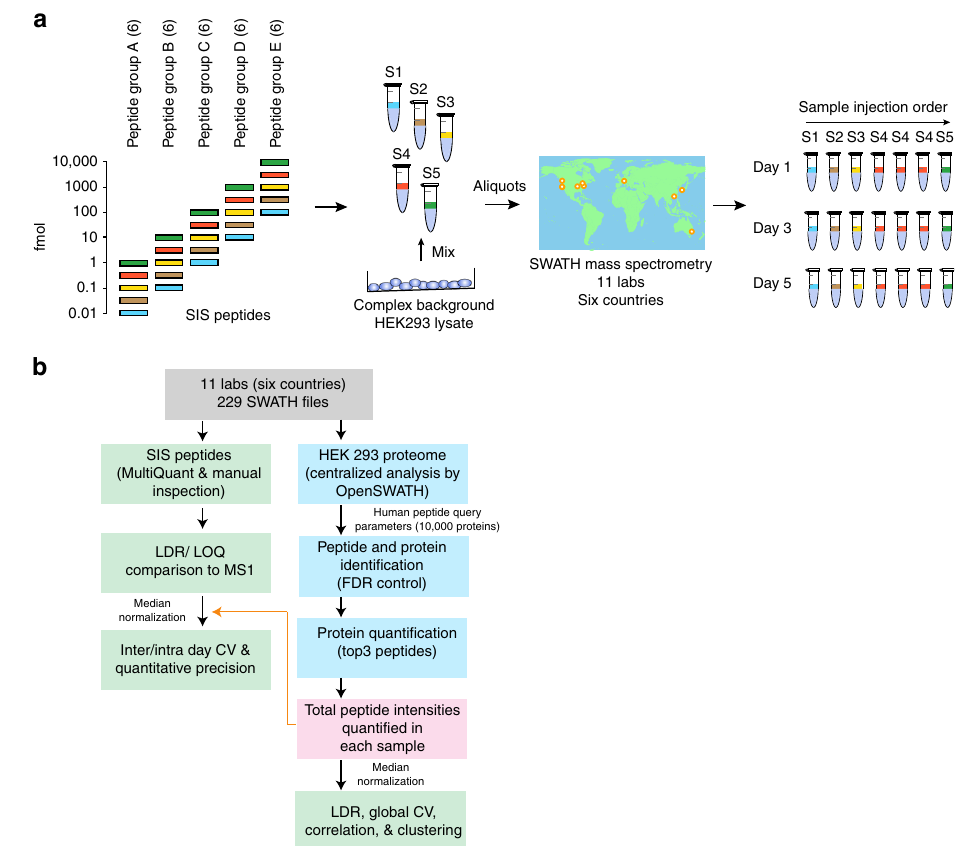
Fig. 1 Study design and implementation. a A set of 30 SIS peptides partitioned into fi ve groups (A – E, six peptides in each) were diluted into a HEK293 cell lysate to span a large dynamic range. Starting at a different upper concentration for each group, they were threefold diluted into the matrix to cover a concentration range from 12 amol to 10 pmol in 1 µ g of cell lysate. This created a set of fi ve samples to be run by SWATH-MS on the TripleTOF 5600/5600+ system at each site. Each sample was run once per day on day 1, 3, and 5, with the exception of sample 4 which was run 3× on each day. b After data acquisition, the 229 SWATH-MS fi les were assembled centrally and processed using two strategies. The SIS peptide concentration curves were assessed using MultiQuant Software, allowing for the determination of linear dynamic range ( LDR ), and LLOQs for each peptide. In addition, the intra- and inter-day CVs were determined before and after normalization. The HEK293 proteome matrix data was analyzed using the OpenSWATH pipeline and the Combined Human Assay Library consisting of ~10,000 proteins. The false discovery rate was controlled at the peptide query and protein level using PyProphet. Protein abundances were inferred by summing the top fi ve most abundant fragment ions from the three most abundant peak groups using the aLFQ software. We then used protein abundances to cluster, and compute Pearson correlation coef fi cients, for all samples from all